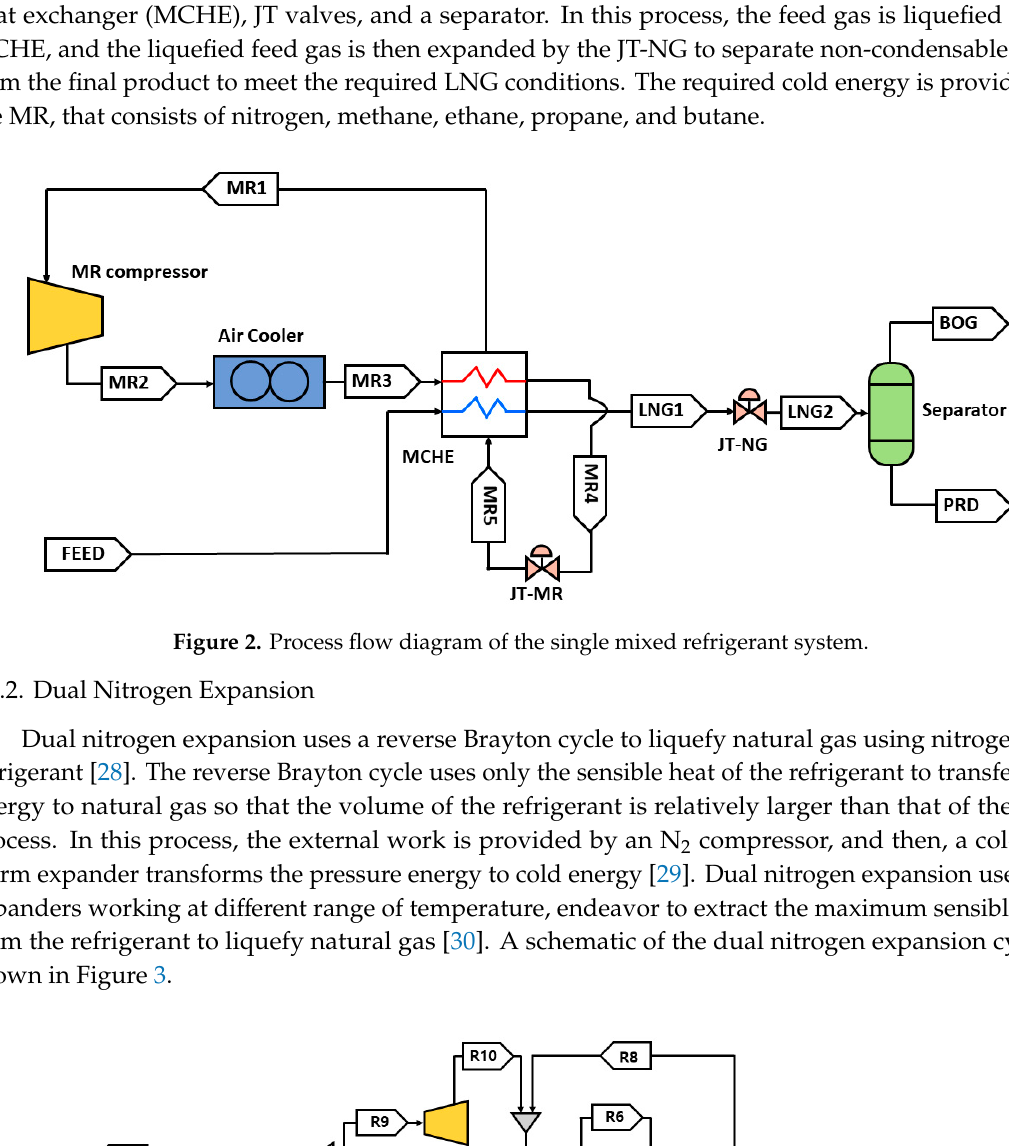
Figure 1. Illustration of a movable liquefied natural gas liquefaction plant.